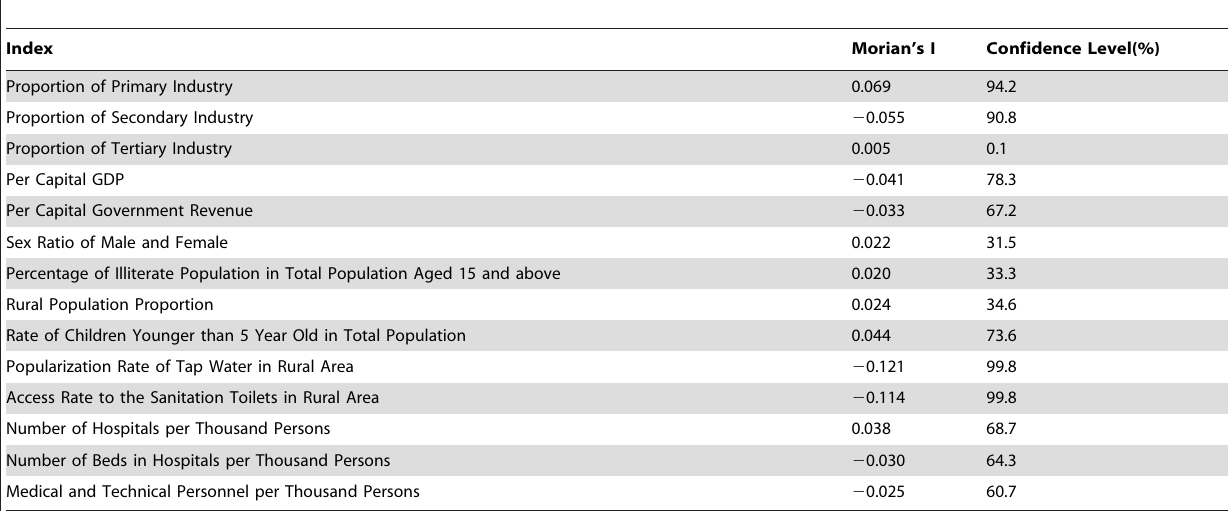
Table 1. Morian’s I and the confidence level between the morbidity of bacillary dysentery and the socio-economic factors.